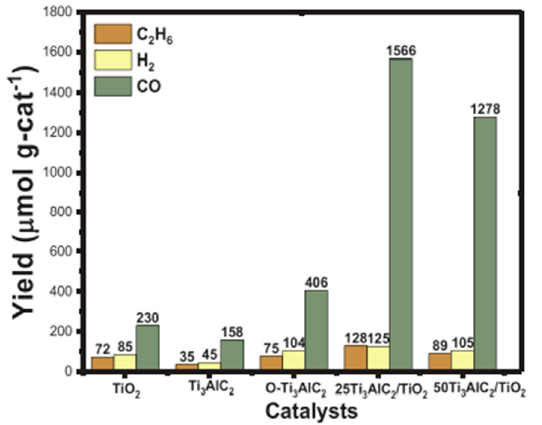
Figure 22. Effect of Ti 3 AlC 2 loading on the performance of TiO 2 for photocatalytic dry reforming of methane. Copyright (2020), reprinted from [36] with permission from Elsevier.